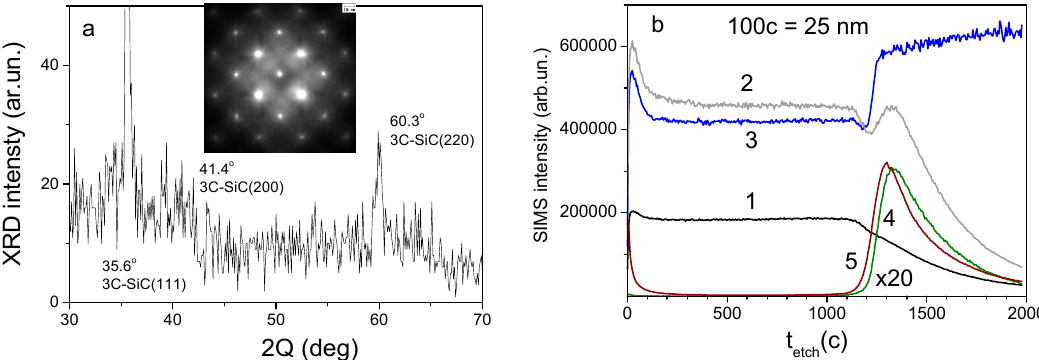
Figure 2. X-ray diffraction and electron diffraction patterns ( a ) and distribution according to secondary ion mass spectrometry (SIMS) data ( b ) of main elements in the growing carbide layer (SiC (1), 12 С (2), 28 Si 2 (3), 74 Ge (4), 16 O (5)) for the sample corresponding Figure 1b.